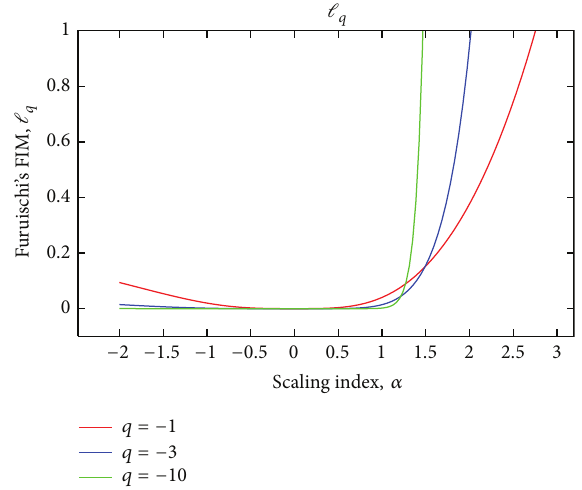
Figure 4: Generalized wavelet Fisher’s information for several values of the parameter 𝑞 ( 𝑞 negative). As 𝑞 becomes more negative,